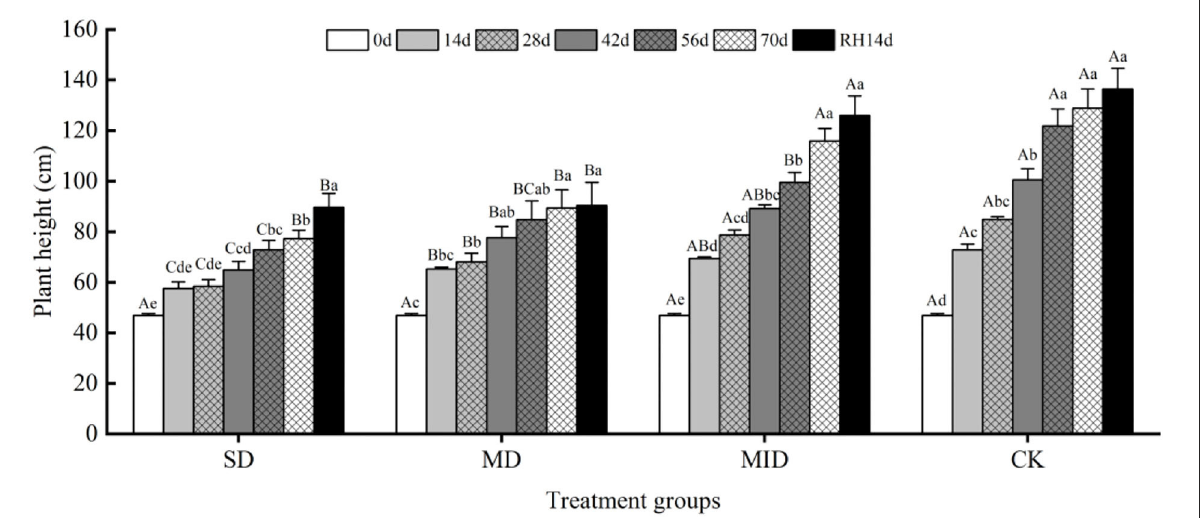
FIGURE3 Plant height during the drought and rehydration for A. selengensis . 0 day, 14 days, 28 days, 42 days, 56 days, 70 days, and RH, 14 days, respectively represent 0th, 14th, 28th, 42nd, 56th, 70th under drought and 14th day of rehydration. Severe drought group (SD), moderate drought group (MD), mild drought group (MID), control group (CK). Different capital letters stand for significant differences between different drought groups ( p < 0.05), and different lowercase letters stand for significant differences between different experimental times ( p < 0.05).